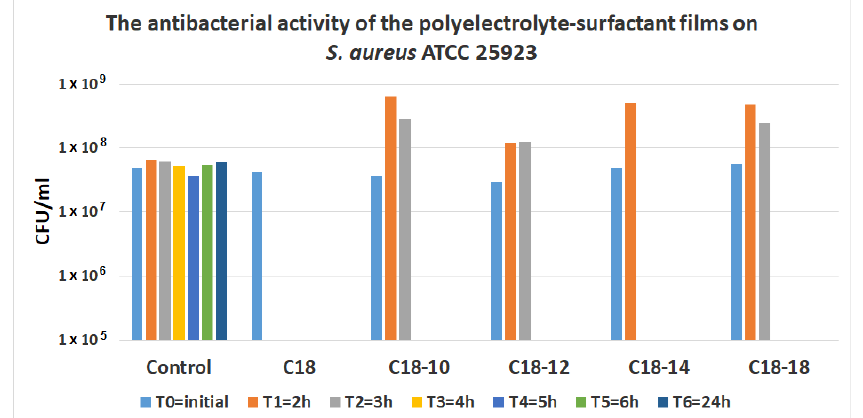
Figure 3. The antibacterial activity of the polyelectrolyte – surfactant films on Staphylococcus aureus ATCC 25923 at different times of contact (initial, 2, 3, 4, 5, 6, and 24 h): (control — clear glass, C18-(PAC 18 Na/PDADMAC) 20 , C18-10-(PAC 18 Na-C 10 TAB/PDAMAC) 20 , C18-12-(PAC 18 Na-C 12 TAB/ PDAMAC) 20 , C18-14-(PAC 18 Na-C 14 TAB/PDAMAC) 20 , and C18-18-(PAC 18 Na-C 18 TAB/PDAMAC) 20 .